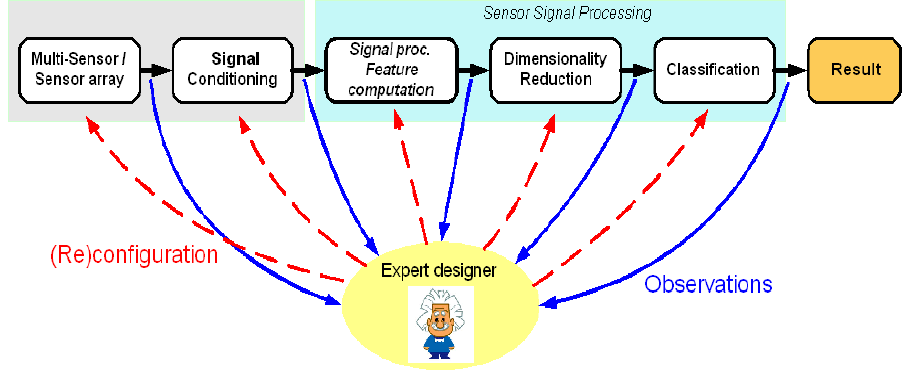
Figure 1. Block diagram of typical intelligent multi-sensor system. The design in each step or block depends human observation and assistance.